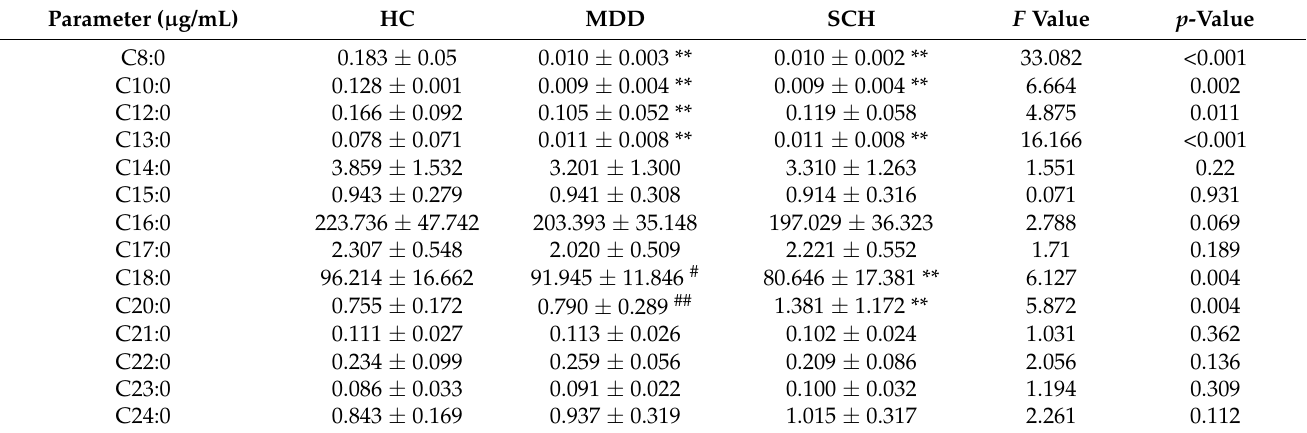
Figure 2. Comparison of concentrations of medium- and long-chain fatty acids among HC, MDD, and SCH participants. Comparison of the concentration of total FA ( A ), total SFA ( B ), total MUFA ( C ), total PUFA ( D ), total N3 ( E ), total N6 ( F ) and the ratio of N6/N3 ( G ). ( H ) Correlation between clinical parameters and changed fatty acids. Red squares show a positive correlation and blue squares show a negative correlation, * p < 0.05; ** p < 0.01. Abbreviations: FA, fatty acids; SFA, saturated fatty acids; MUFA, monounsaturated fatty acids; PUFA, polyunsaturated fatty acids; N3, omega-3 polyunsaturated fatty acids; N6, omega-6 polyunsaturated fatty acids. Table 3. Comparison of FA among the three groups.